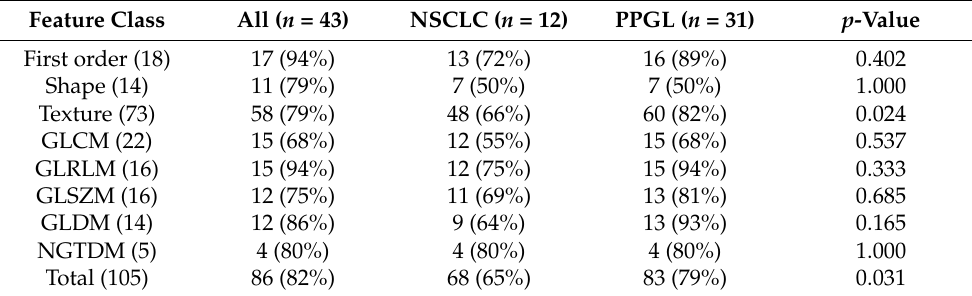
Table 2. Numbers and percentages of features affected by the delineation method (VOI vital-tumour vs. VOI gross-tumour ) per feature class for the different cohorts and both cohorts together. Differences in the number of affected features between cohorts were assessed using the Fisher’s exact test. NSCLC: non-small cell lung carcinoma, PPGL: pheochromocytoma and paraganglioma, GLCM: grey level cooccurrence matrix, GLRLM: grey level run length matrix, GLSZM: grey level size zone matrix, GLDM: grey level dependence matrix, NGTDM: neighbouring grey tone difference matrix.